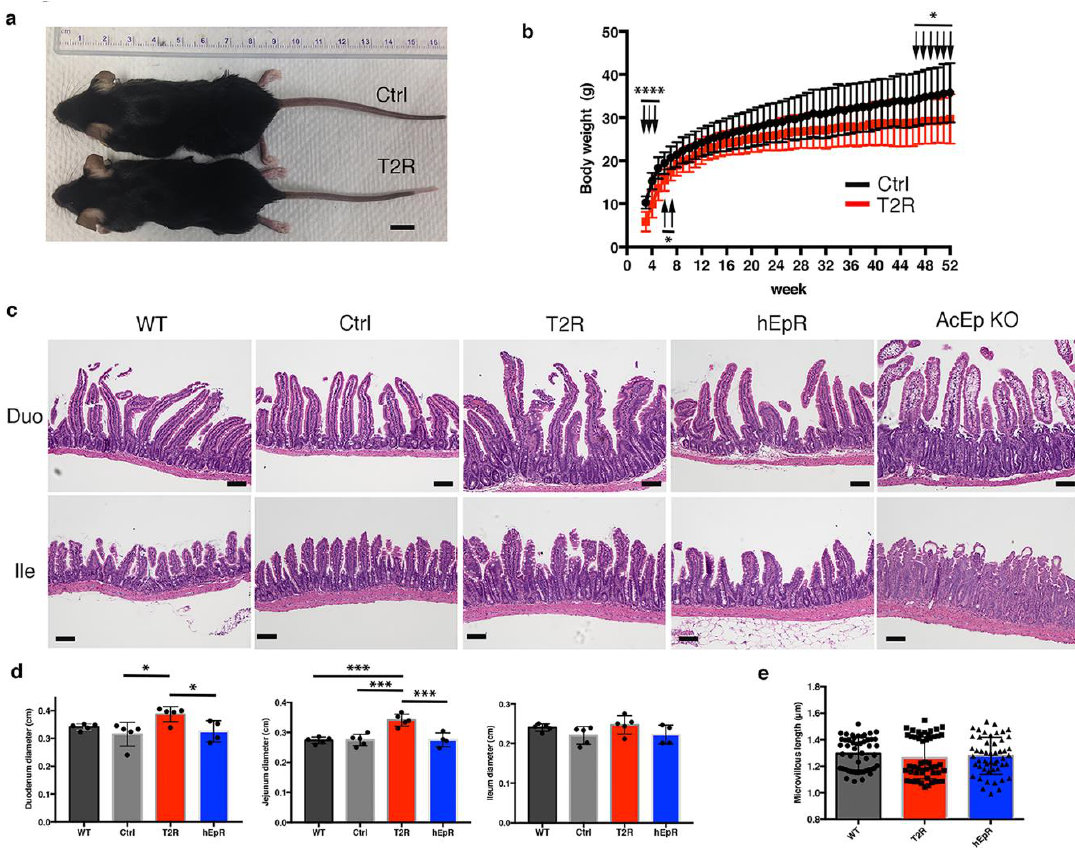
Figure 2. TROP2 expression in IEC prevents congenital tufting enteropathy in EpCAM knockout mice. ( a ) Representative photographs of littermate control mice (EpCAM +/ − TROP2 Tg ; Ctrl (T2)) and T2R (EpCAM − / − TROP2 Tg ) mice at 8 weeks of age. Scale bar, 1 cm. ( b ) Serial body weights of littermate Ctrl and T2R mice over 1 year. Data depicted represent means ± SD for 32 Ctrl mice and 24 T2R mice at each time point. * p < 0.05, **** p < 0.0001 using a multiple t test and the Holm–Sidak method. ( c ) Representative H & E-stained histologic sections of small intestine from relevant mouse strains. AcEp KO designates tissue obtained from 8-week-old EpCAM fl / fl ROSA CreER transgenic mice 7 days after initiation of tamoxifen treatment. Scale bars, 100 µ m. ( d ) Intestinal diameters from relevant mice. Data represent means ± SD for 5 mice in WT, Ctrl, and T2R groups and for 4 mice in the hEpR group. * p < 0.05, *** p < 0.001 using a one-way ANOVA with Tukey’s multiple comparison test. ( e ) Intestinal microvillus length determined in transmission electron micrographs of tissue of indicated mice. Data depicted represent means ± SD of 50 microvilli for each